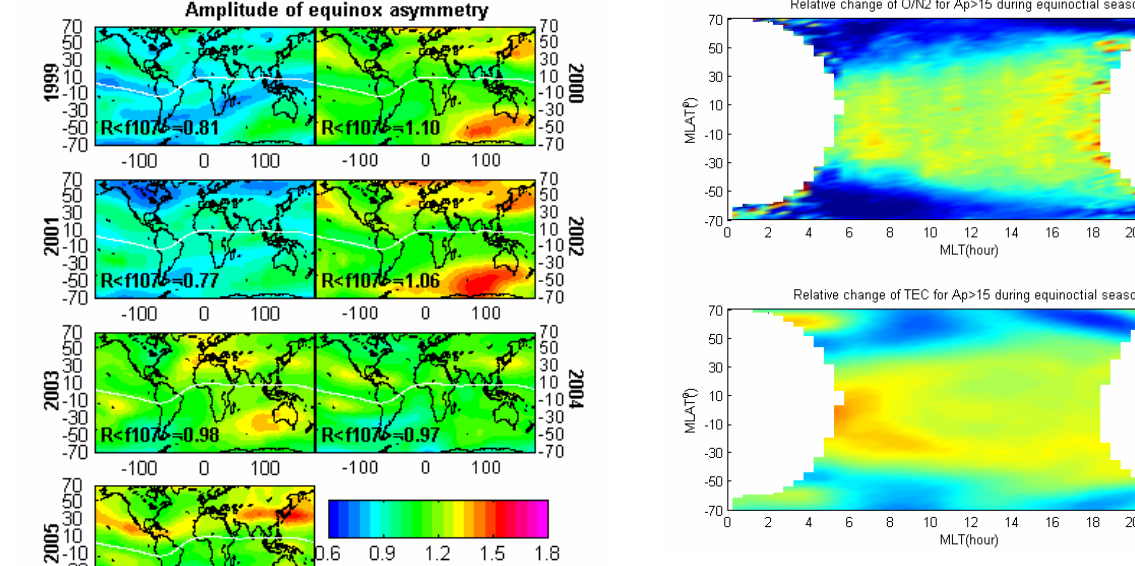
Fig. 7. Distribution of the relative change in [O/N2] and TEC under Figure 7. Distribution of relative change of [O/N2] and TEC under the the condition Ap> 15 during equinoctial seasons. condition Ap>15 during equinoctial seasons.